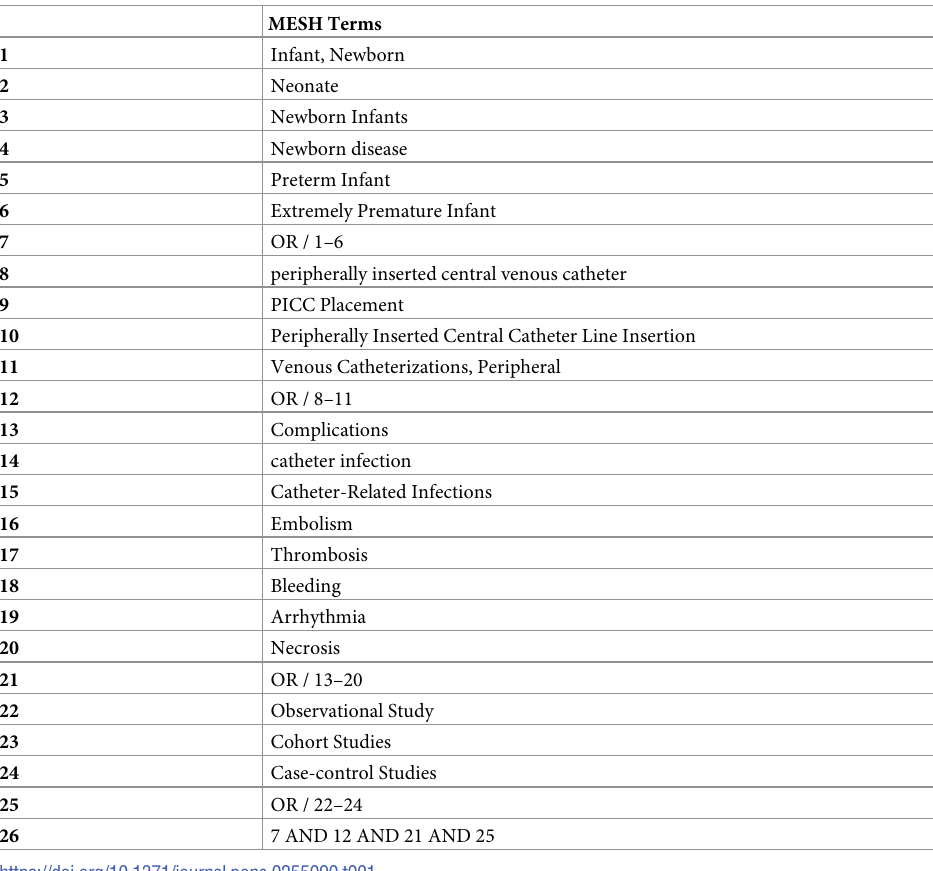
Table 1. Search strategy for